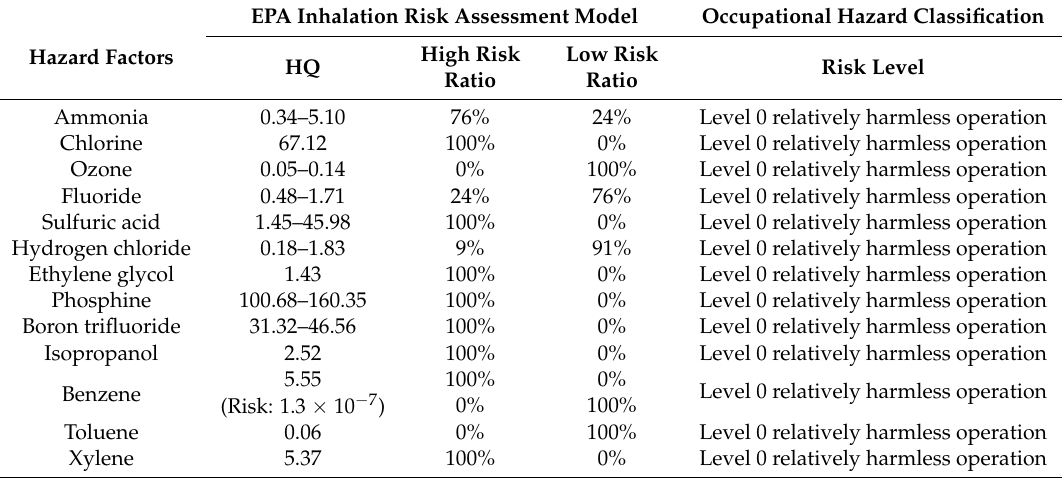
Table 5. Evaluation results of two methods of occupational hazards classification for the electronic chip manufacturing